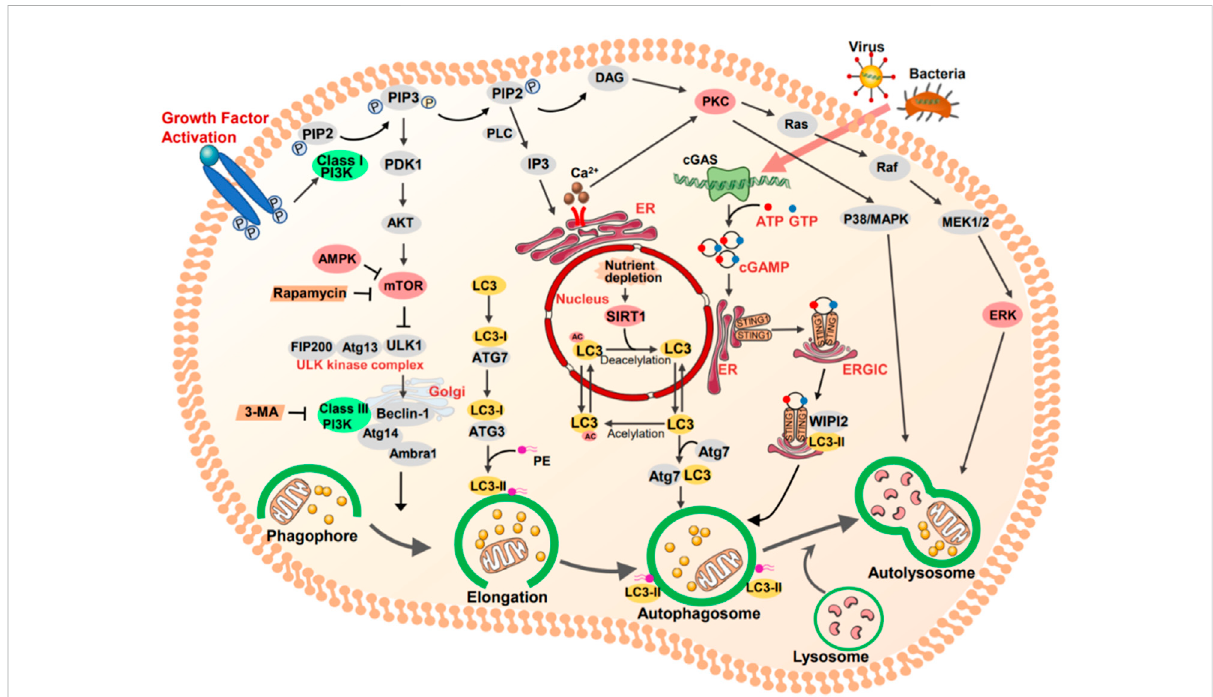
FIGURE 2 The key targets and signal pathways involved in autophagy. Class I PI3K (PI3K) is activated by growth factor, which as a primary effector downstreamofRTKsorGPCRs.Subsequently,thesestimulitransduceintointracellularmessagesbyphosphorylationofPtdIns(4,5)P2(PIP2)toform PtdIns(3,4,5)P3(PIP3).Inturn,theserine/threoninekinaseAKTandotherdownstreamareactivated. Mammaliantargetofrapamycin(mTOR)canbe activated by RAC α serine/threonine protein kinase (AKT) and is a negative modulator of autophagy. AMP-activated protein kinase (AMPK) activated by several upstream kinases and inhibited mTORC1 to induce autophagy. Protein kinase C (PKC), as an autophagic regulator, modulating otherproteins through phosphorylating serine andthreonineaminoacid residues. Ras/RAF/MER/ERKsignaling functions downstreamofPKC.Once MEKisactivated,itphosphorylatesERK,andpromotesautophagy.STING1locatestotheendoplasmicreticulum(ER)membraneinimmuneandnon- immune cells, which activated by bacteria CDNS or CGAS-produced cGAMP. cGAMP binds to STING1, contributing to it translocated from ER to ERGLC, leading the formation of